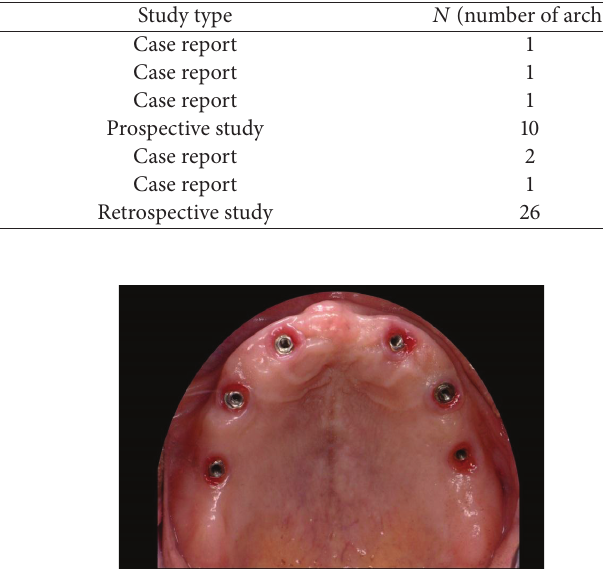
Figure 1: Maxillary occlusal view after tissue